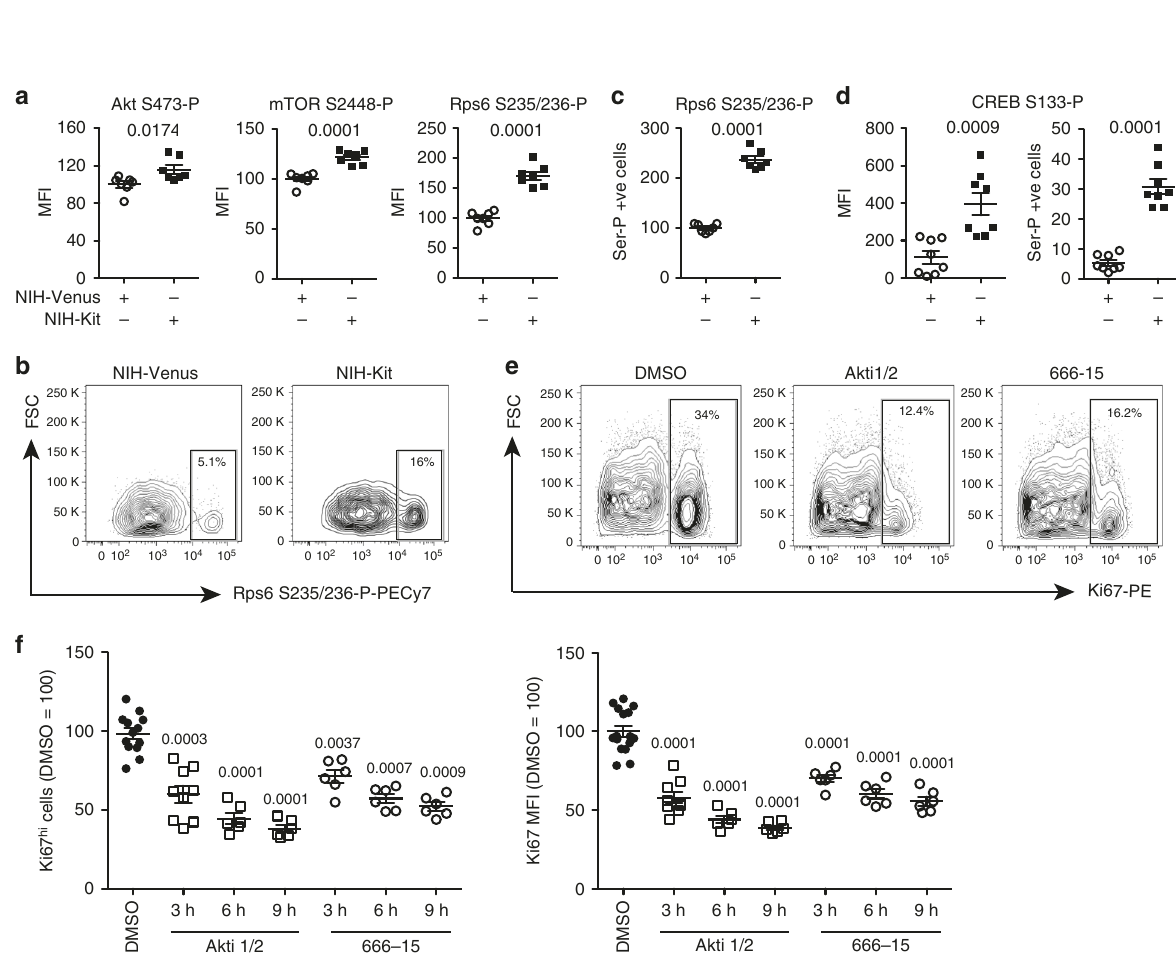
Fig. 3 Activation of the Akt/mTOR pathway by reverse mKitL signaling. a Intracellular fl ow cytometry analysis of Akt S473, mTOR S2448, and Rps6 S235/ S236 phosphorylation in NIH3T3 cells co-cultured with NIH-Venus or NIH-Kit cells as indicated ( N = 7, two experiments). Values are normalized MFI (NIH-Venus mean = 100). Bars show mean ± s.e.m. P -value is shown (Student ’ s t -test). b Representative intracellular fl ow cytometry plots measuring Rps6 S235/S236 phosphorylation in NIH3T3 cells co-cultured with NIH-Venus or NIH-Kit cells, as indicated. Gating shows cells with high phospho-Rps6 levels. Data are representative of seven experiments. c Percentage of phospho-Rps6 positive cells in NIH3T3 cells co-cultured with NIH-Venus or NIH-Kit cells in b ( N = 7, two experiments). Bars show mean percentage of S235/S236 positive cells ± s.e.m normalized to the average value for NIH-Venus ( = 100). P - value is shown (Student ’ s t -test). d CREB phopho-Ser133 MFI (left) and percentage CREB phopho-Ser133 positive cells (right) in NIH3T3 cells co-cultured with NIH-Venus or NIH-Kit cells, as indicated ( N = 8, two experiments). Bars show mean ± s.e.m. P- value is shown (Student ’ s t -test). e Representative intracellular fl ow cytometry plots measuring Ki67 in NIH3T3 cells co-cultured with NIH-Kit cells and treated for 9 h with DMSO, Akt inhibitor (Akti1/2) or CREB inhibitor (666 – 15), as indicated. Gating shows the Ki67 high population. f Percentage of Ki67 high cells (left) and Ki67 MFI (right) in NIH3T3 cells co- cultured with NIH-Kit cells and treated for 3, 6, or 9 h (as indicated) with DMSO ( n = 13, two experiments), Akt inhibitor (Akti1/2), or CREB inhibitor (666 – 15), as indicated ( N = 6, two experiments, except the Akti1/2 3 h time point where N = 9, two experiments). Bars show mean ± s.e.m. P- value